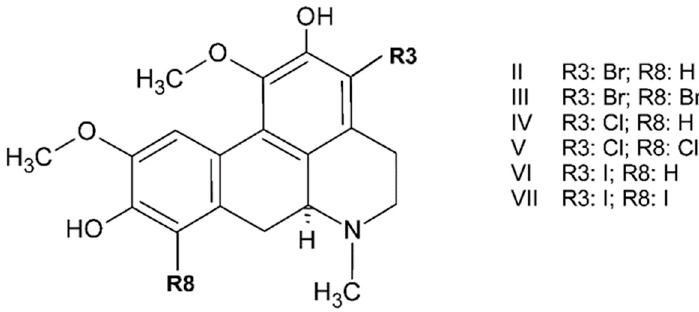
Figure 3. Molecular structure of boldine derivatives determined by Sobarzo et al. [93].